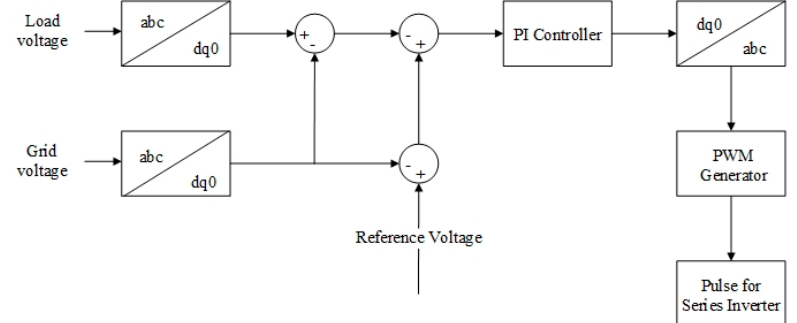
Figure 6. Series voltage source converter control logic.